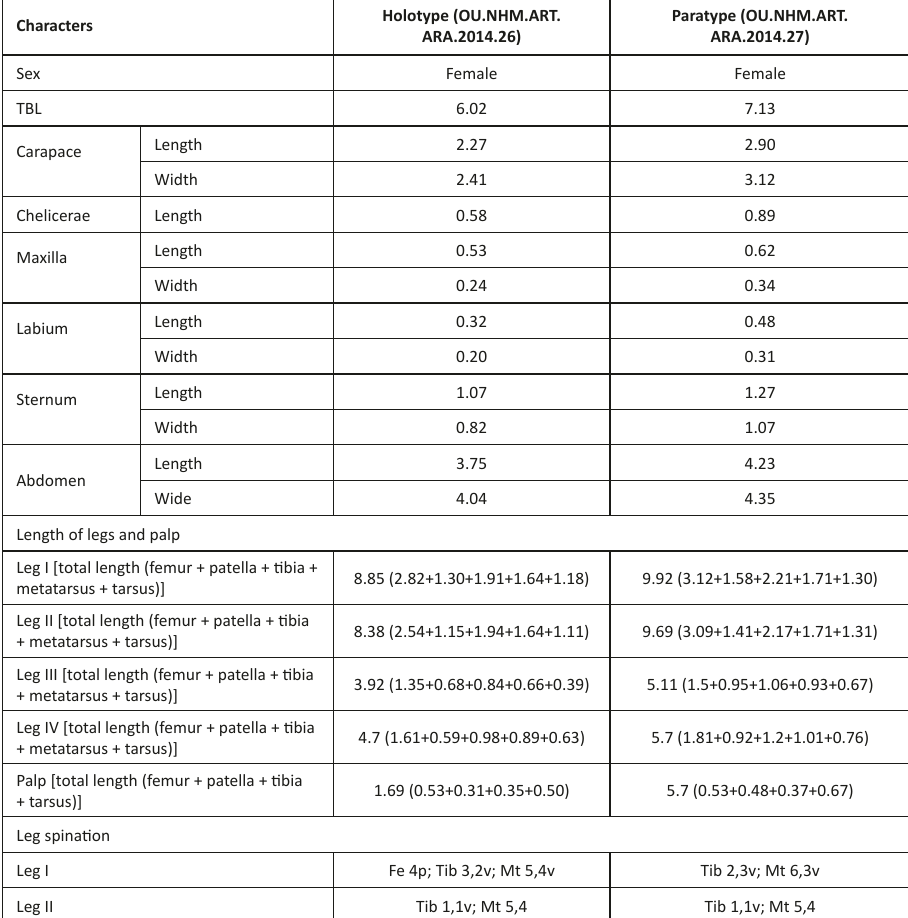
Table 1. Comparison of external measurements (in mm) of body parts of the holotype and paratype of Thomisus telanganaensis sp. nov. Characters